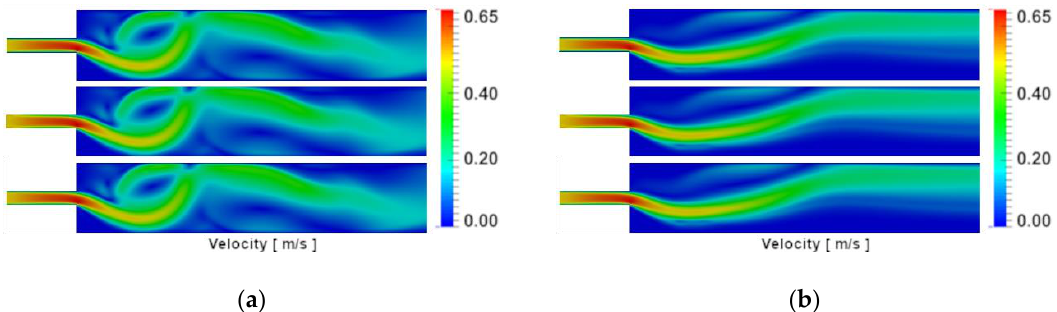
Figure A4. Velocity profiles of at ( a ) t = 2 s; ( b ) t = 25 s. From top to bottom the contours are the simulation results of 3D grid sampled at plane z = 0, 3D grid sampled at plane z = −0.4 L z , and the “regular” 2D grid.